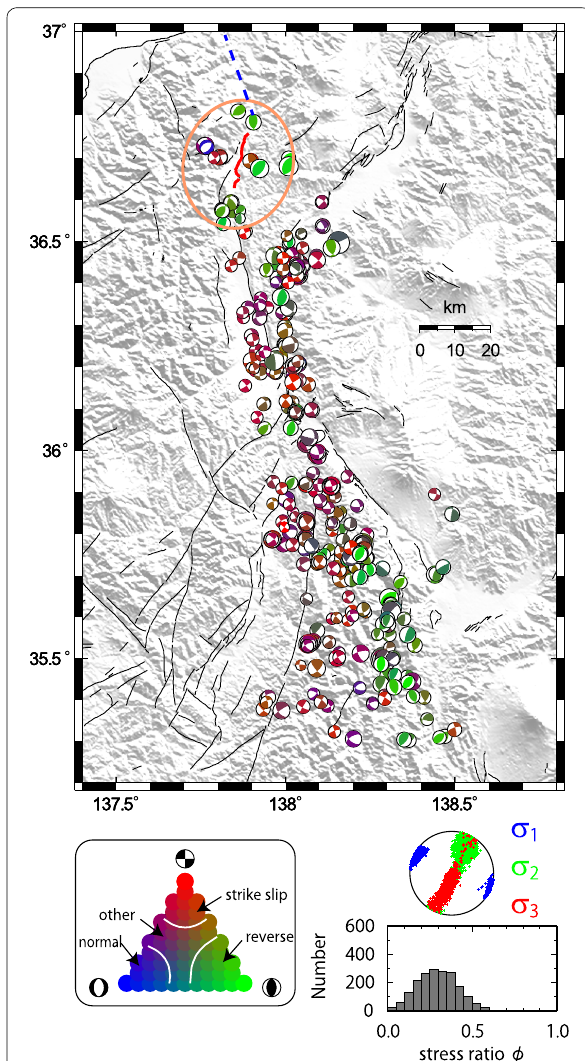
Fig. 1 Observed focal mechanisms and principal stress state obtained before the 2014 Northern Nagano earthquake. The map view shows the focal mechanisms picked along the Itoigawa- Shizuoka tectonic line (ISTL) (see the legend for colored indicating the faulting types); the black lines denote the active fault traces, and the Kamishiro fault is highlighted by the red line (after Nakata and Imaizumi 2002). The broken blue line roughly indicates the currently inactive part of the ISTL. The lower panels show the estimated directions of the principal stress axes (stereo net) and the estimated value of stress ratio φ (histogram) obtained in the circled area (after Imanishi et al.